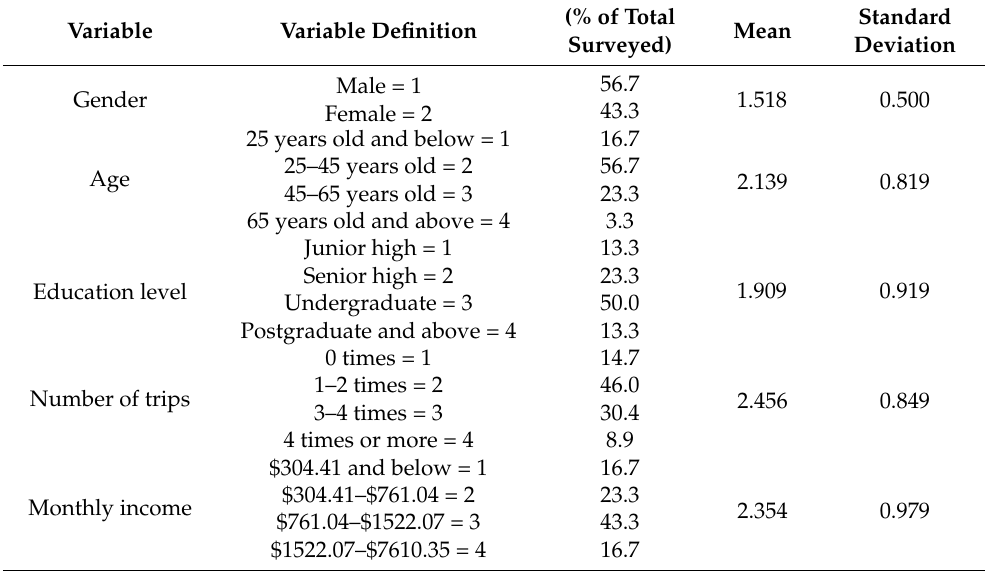
Table 5. Descriptive statistics of the